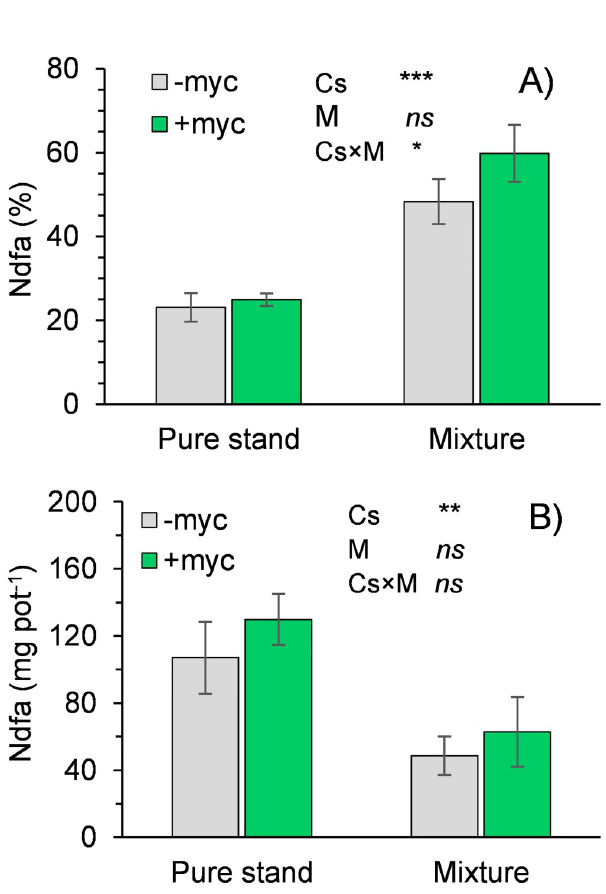
Fig 3. N derived from the atmosphere (Ndfa) as a percentage of total N content (A) and as the amount of N fixed (B) in the aboveground biomass of faba bean. Cs, cropping system (pure stand, mixture); M, absence (–myc) or presence (+myc) of arbuscular mycorrhizal fungi (AMF). � , �� , and ��� indicate significant differences at P � 0.05, 0.01, and 0.001, respectively; ns indicates nonsignificant differences. Vertical bars indicate standard errors of each mean value (n =